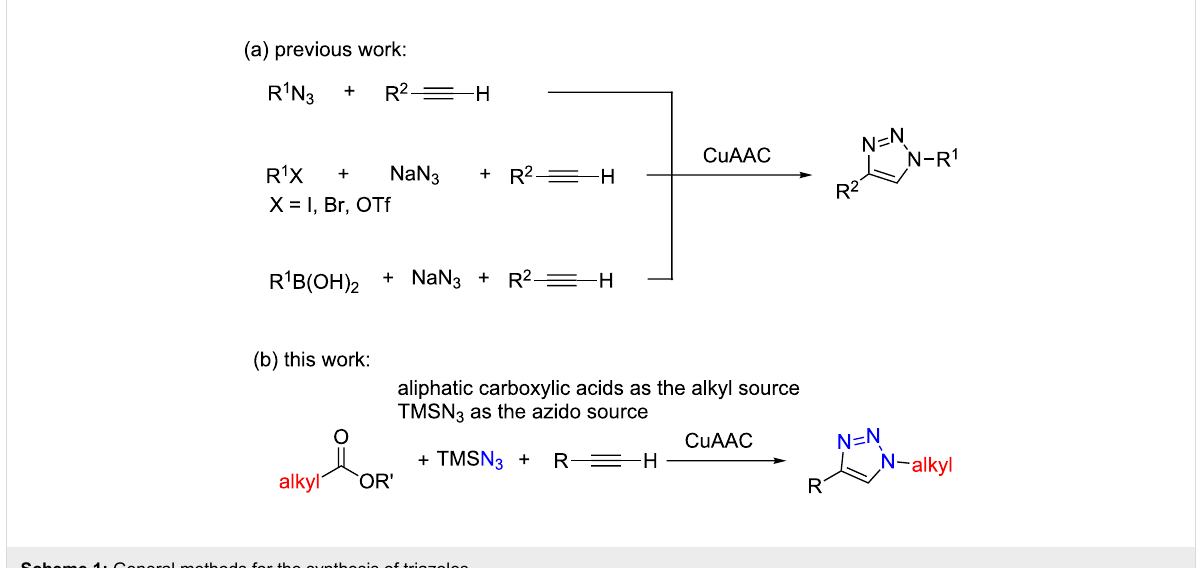
Scheme 1: General methods for the synthesis of